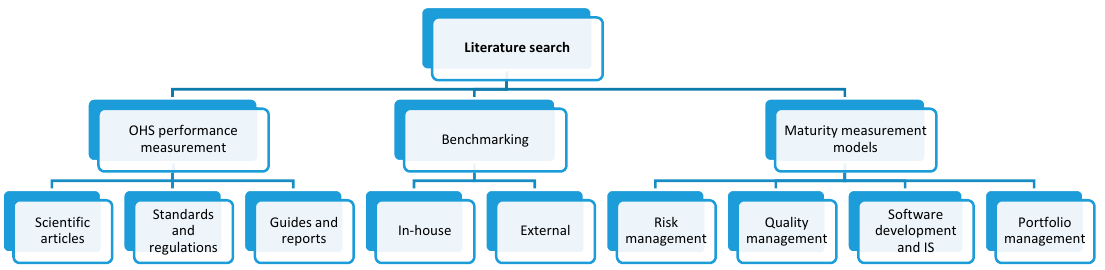
Figure 2. Distribution of risk management maturity indicators in the literature. IS: Information systems.